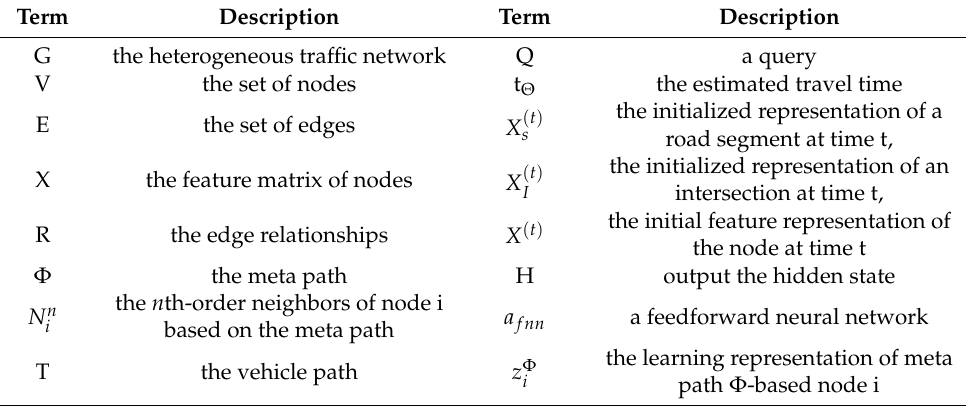
Table 1. Interpretation of